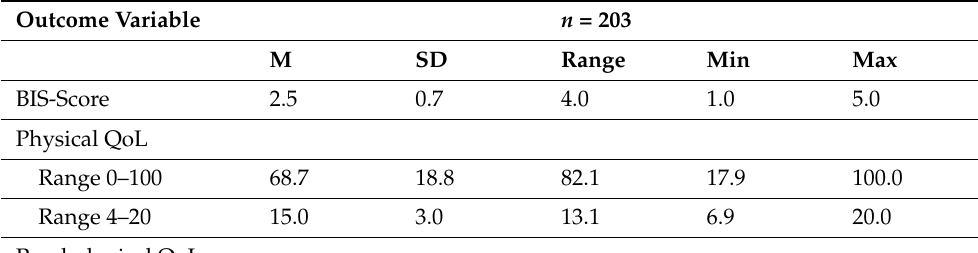
Table 2. Body image and QoL